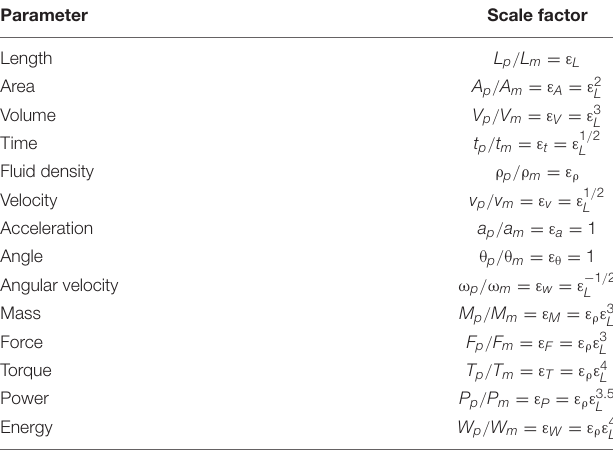
TABLE 1 | Parameters scale factor in the first-stage part. Parameter Scale